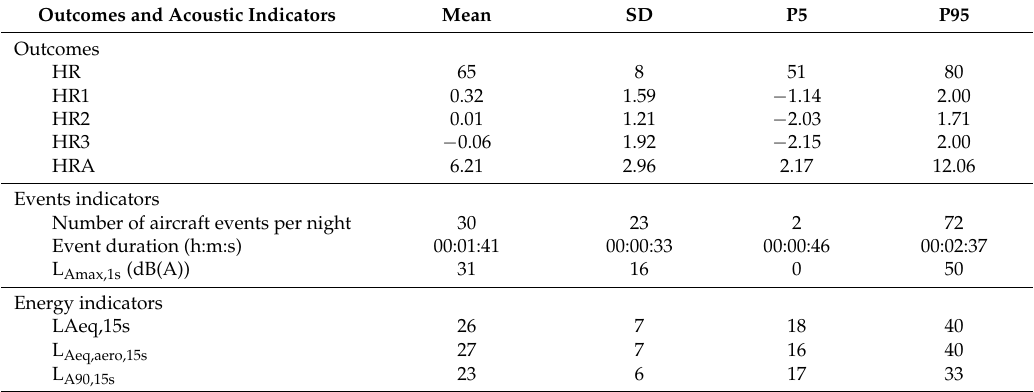
Table 2. Description of the outcomes and sound level indicators.